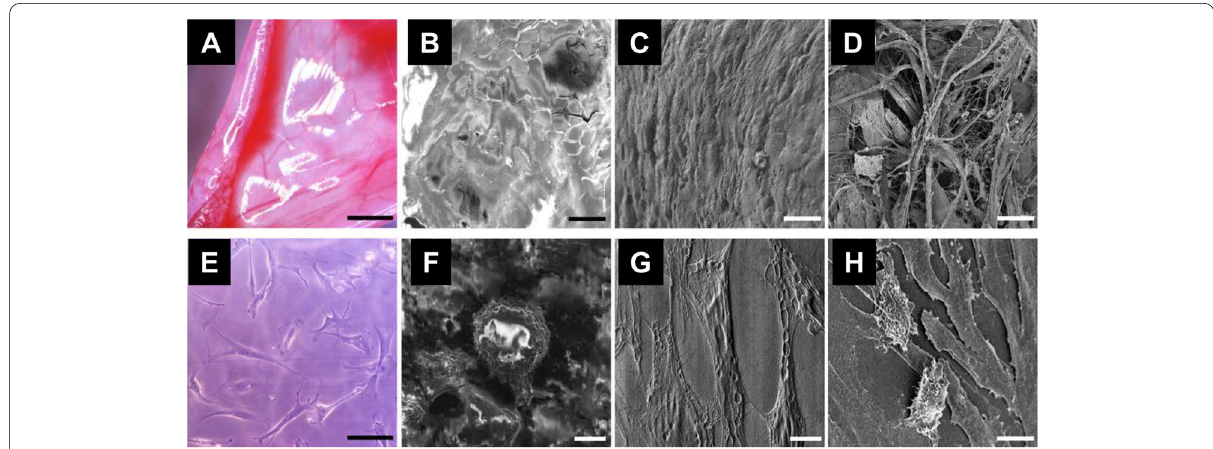
Fig. 3 Mouse peritoneum and embryonic fibroblast cells. A and E Light microscopy images. B and F Untreated specimens. C and G Specimens treated with the surface shield enhancer solution. D and H Specimens conventionally processed. Bar(s) Takaku et al. 2017 with permission from the